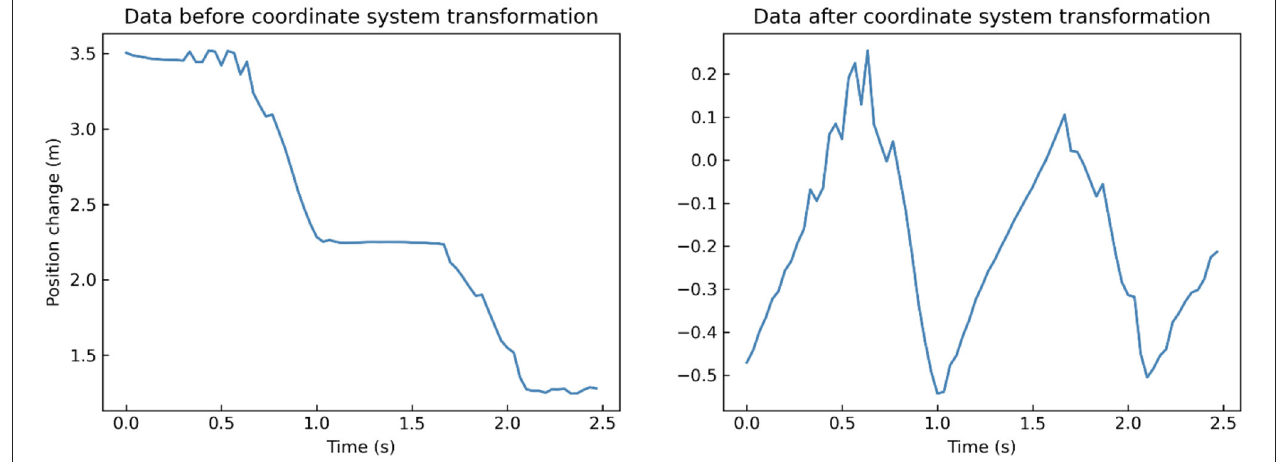
FIGURE 3 | A segment of one participant’s left-foot (joint 24) data on Y-axis when walking toward Kinect before ( left ) and after ( right ) coordinate system transformation.